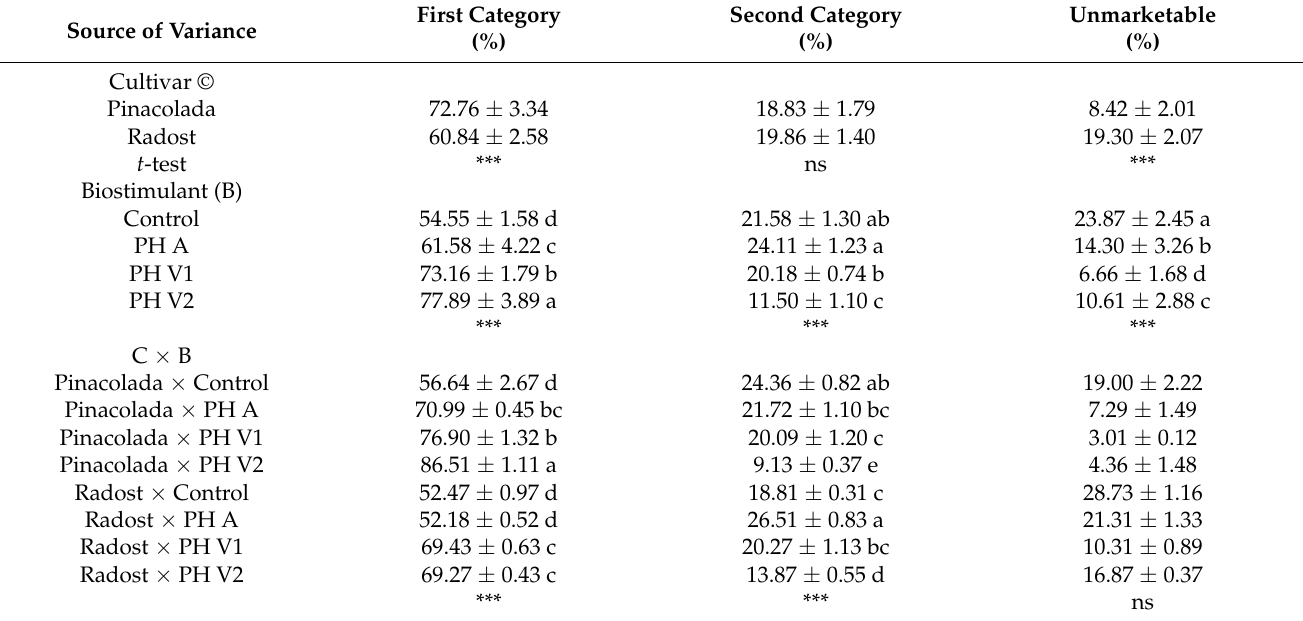
Table 2. The effect of biostimulant treatments (untreated control, one animal PH (PH A, Hicure ® ), or two vegetal PHs (PH V1, Trainer ® and PH V2, Vegamin ® )) on flower categories distribution of two chrysanthemum cultivars (Pinacolada and Radost) under greenhouse conditions. All data are expressed as mean ± standard error; n = 3.